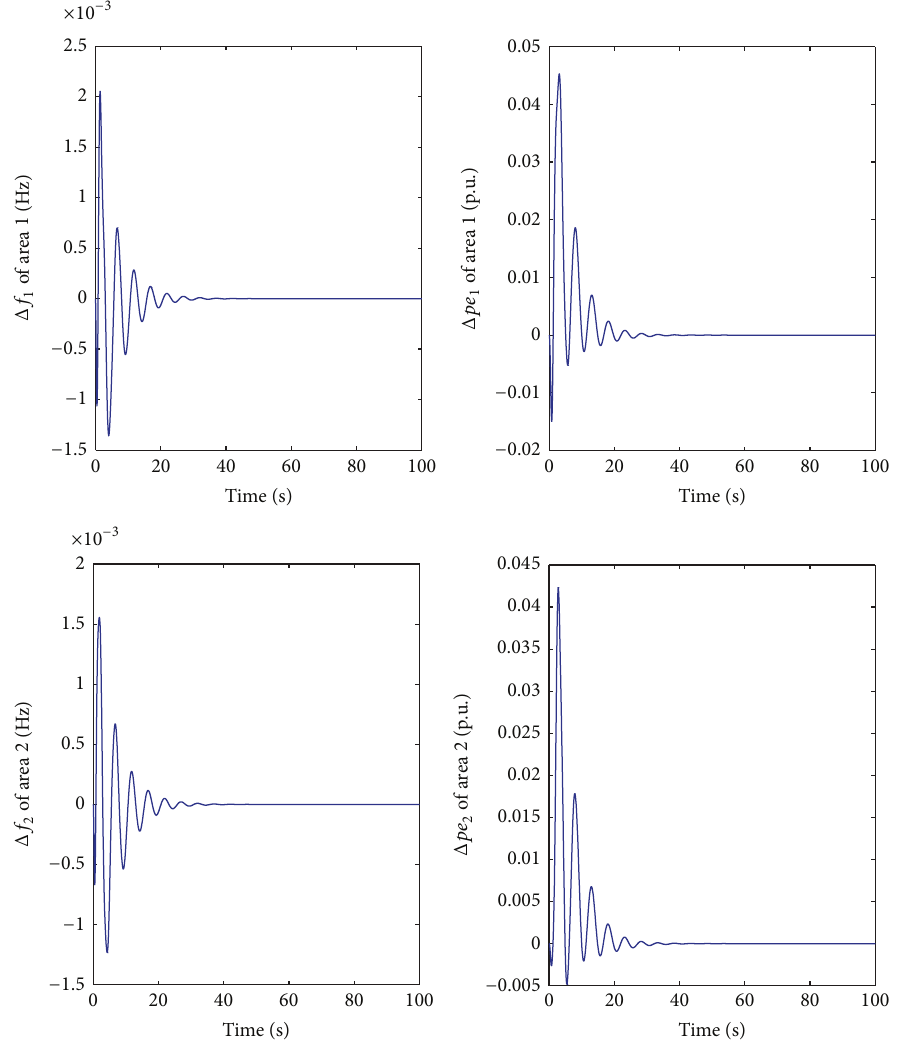
Figure 2: Step load disturbance responses of the original